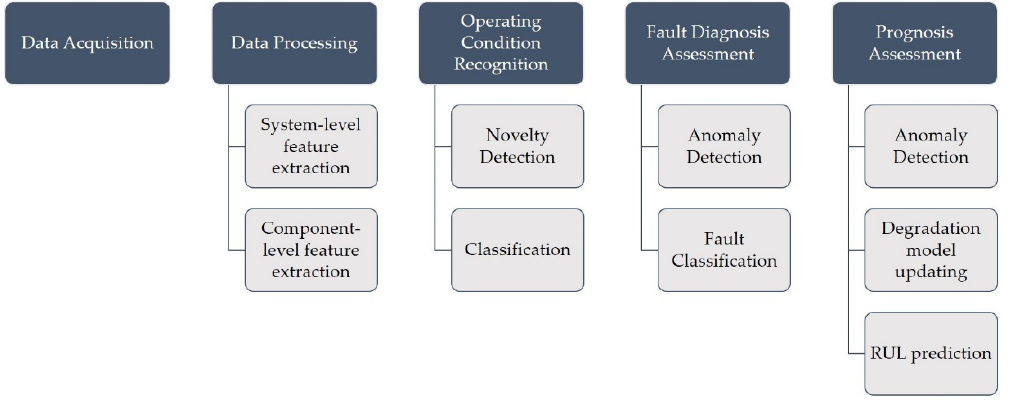
Figure 4. The proposed functional architecture.